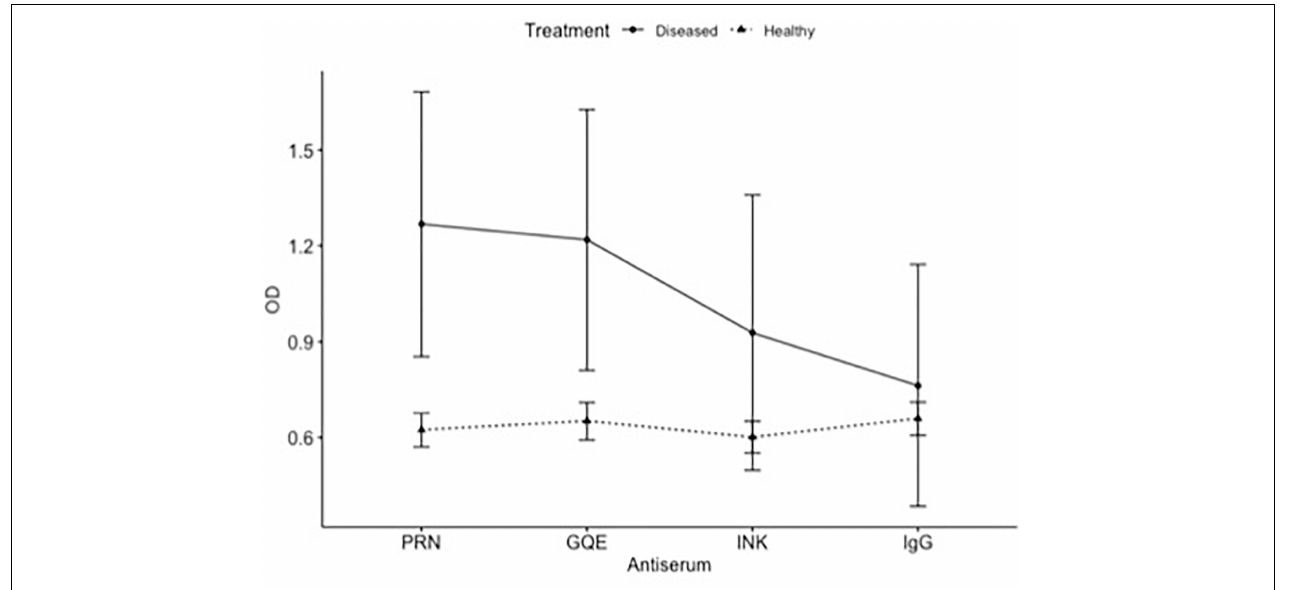
FIGURE 1 | ELISA of healthy and diseased plants. Comparison of absorbance (OD) of the same plants obtained by different antiserum.